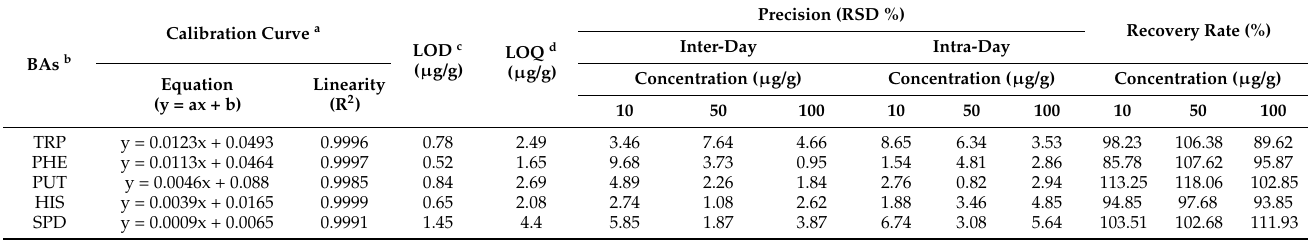
Table 2. Validation for the analysis of BAs (calibration curve, linearity, LOD, LOQ, RSD (%), recovery rate).